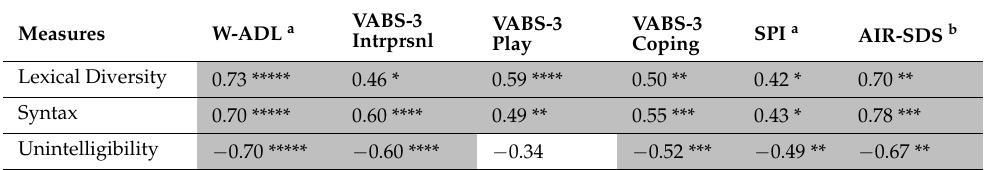
Table 4. Pearson Correlations Between ELS Measures and Independent Functioning Measures.